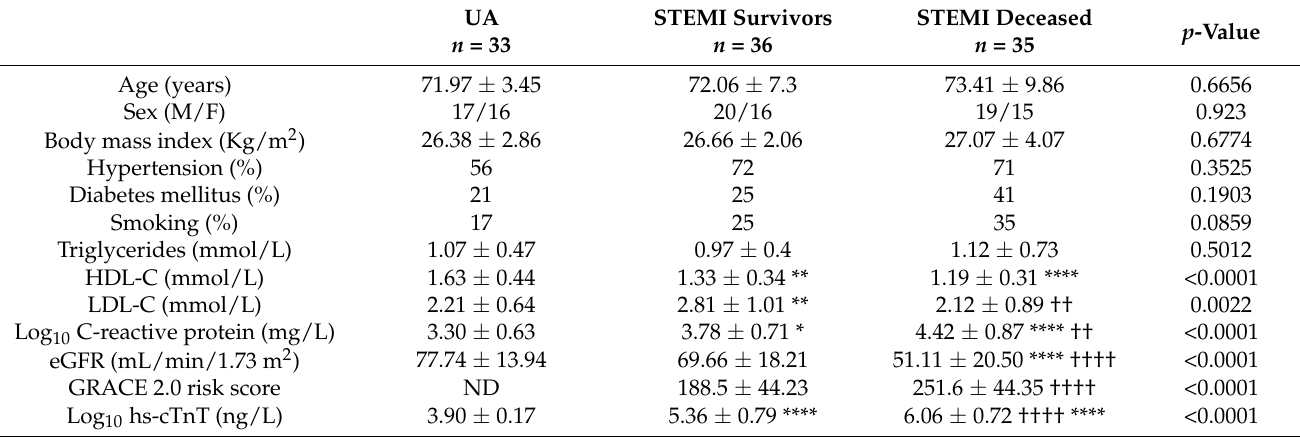
Table 1. Clinical and biochemical parameters of the studied patients at